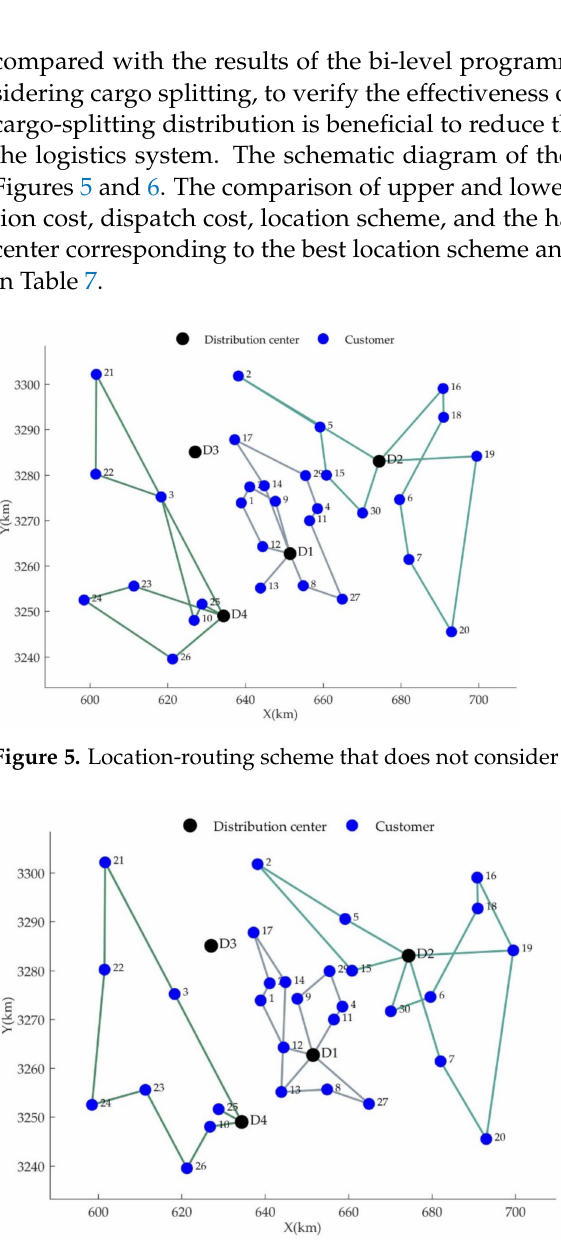
Figure 6. Location-routing scheme that considers cargo splitting. Table 7. The result of location-routing scheme with and without cargo